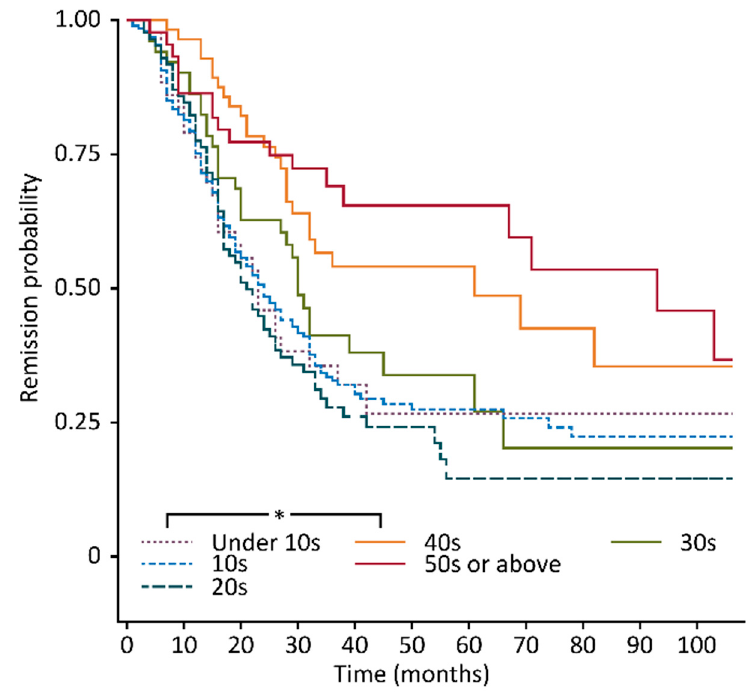
Figure 3. Remission probabilities presented by the Kaplan–Meier curve for each age group. The group with onset in their 20s had the worst remission probability according to the Kaplan–Meier curve, and the groups with onset after age 40 had a significantly better prognosis than those with onset before age 30 (* significant according to the log-rank test with Bonferroni adjustment).